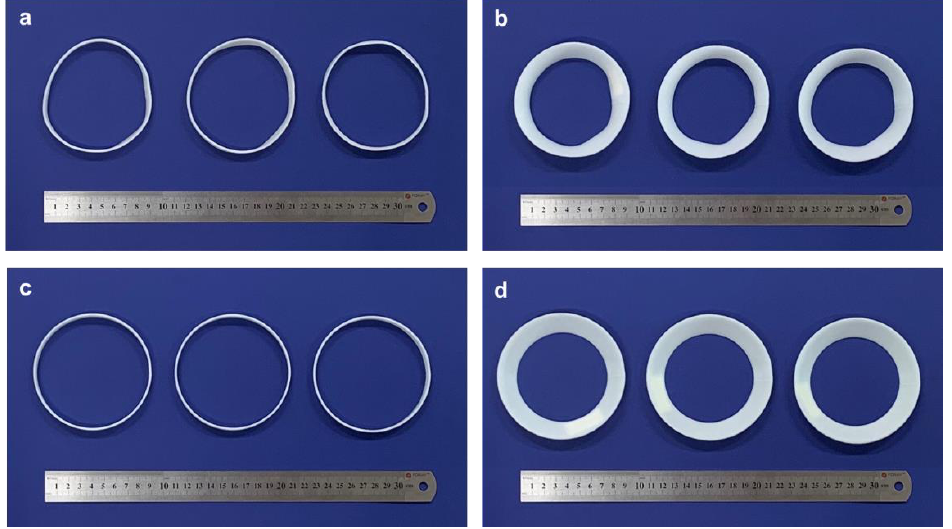
Figure 10. Comparison deformation repeatability: ( a ) unconstrained deformation ( w = 10 mm); ( b ) unconstrained deformation ( w = 20 mm); ( c ) constrained deformation ( w = 10 mm); ( d ) constrained deformation ( w = 20 mm).